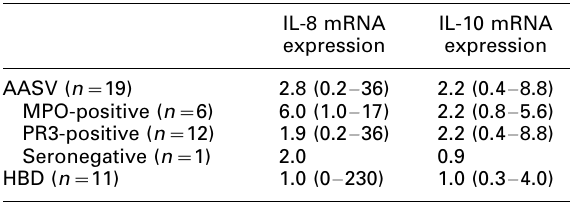
MPO-positive, patients with positive MPO-ANCA; PR3-positive, patients with positive PR3-ANCA. The real-time data are corrected according to the 2 ( (cid:3) DD Ct) formula and are then expressed in relation to the median value of the healthy controls. Results are presented as median